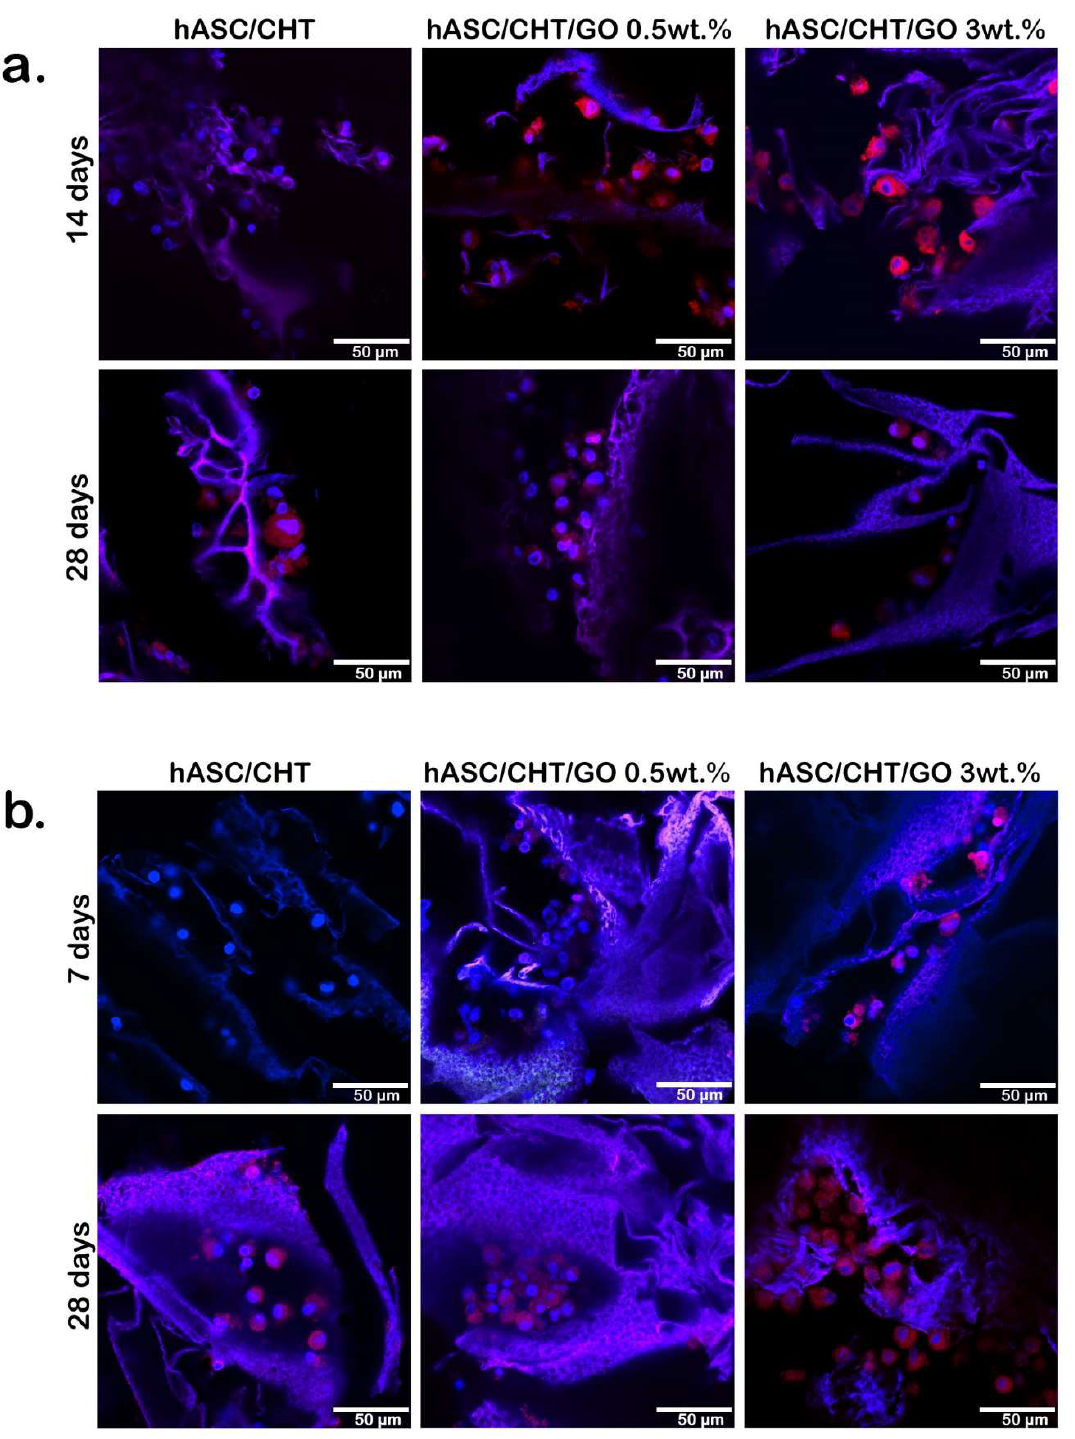
Figure 7. Protein expression of osteogenic specific markers Osx and Opn. ( a ) Osx and ( b ) Opn protein expression as revealed by confocal microscopy in BC, BC0.5, and BC3 up to 28 days of differentiation in pro-osteogenic conditions. The nuclei are labeled in blue with DAPI and Osx/Opn is labeled in red. The scale bar is 50 μm.